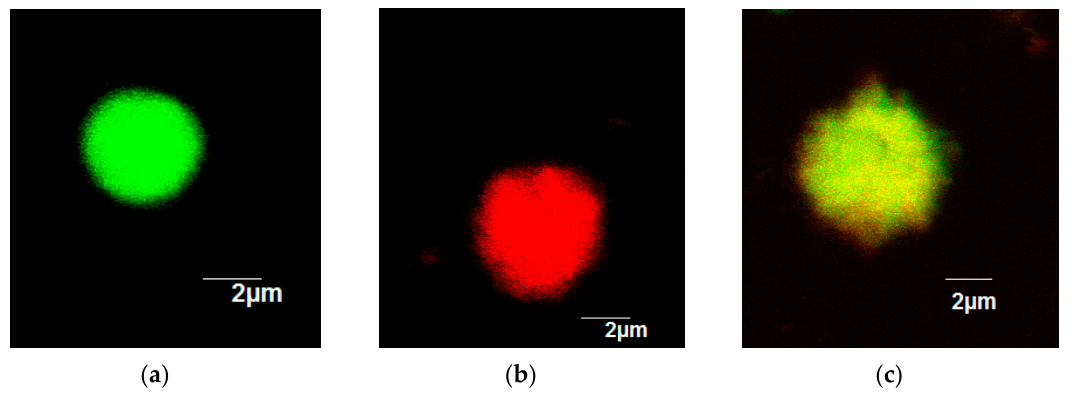
Figure 2. Scanning electron microscopy (SEM) images. ( a ) hexadecylamine ‐ modified polyaspartic acid (HPASP); ( b ) t wo enzymes immobilized on HPASP (SOD ‐ ELP/CAT ‐ ELP@HPASP).